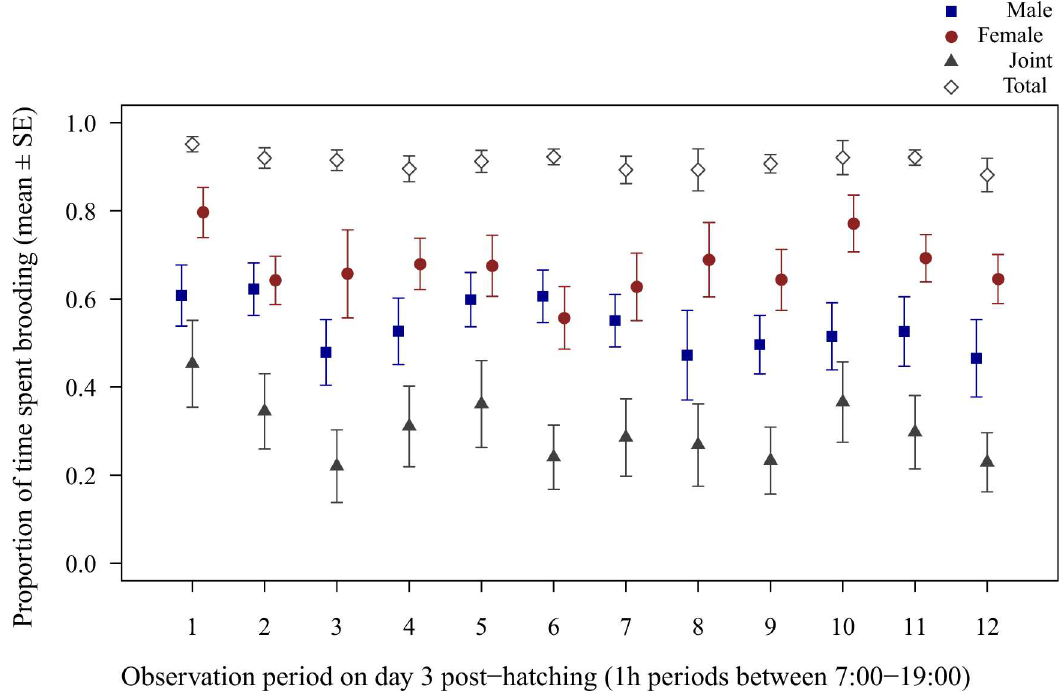
Fig 5. Diurnal variation of parental effort in zebra finches on day 3 post-hatching. Mean ± SE proportionof 1h observation periods spent broodingbetween7:00–19:00.Blue filled squaresrepresent male, red filled circles female, grey filled trianglesjoint (male and female simultaneous) and grey open diamonds total brooding(when at least one parent broods).